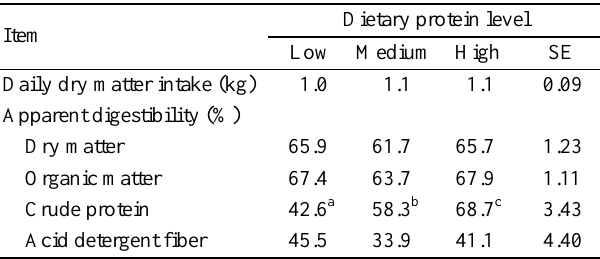
Table 3. Crude protein balance of female spotted deer fed diets with different levels (approximately 7%, 12%, and 17%) of crude